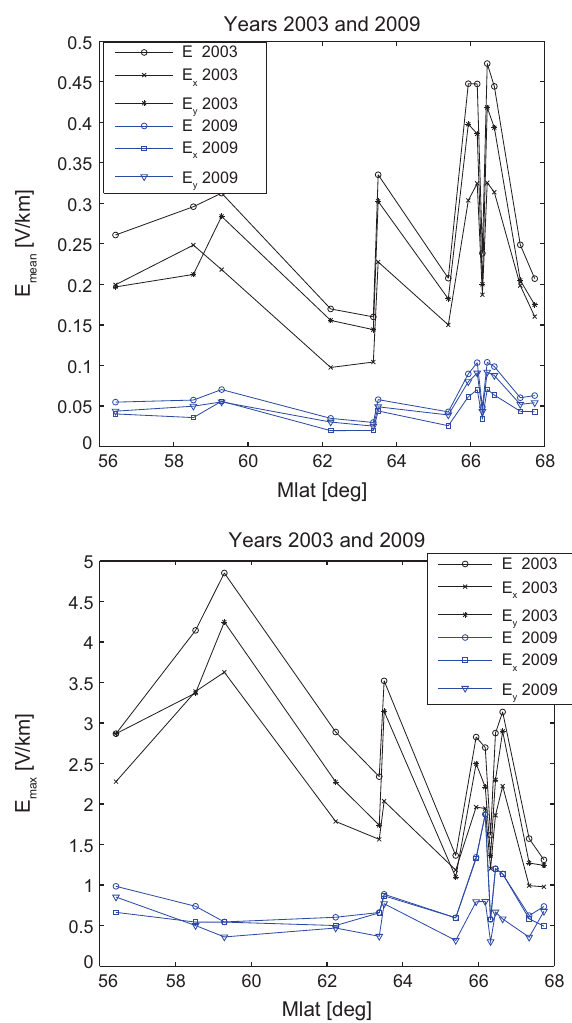
Fig. 6. Average daily maximum and maximum of the modelled 10-s electric field as a function of geomagnetic latitude in 2003 and 2009. Year 2003 represents a very active time and 2009 is geomagnetically quiet.